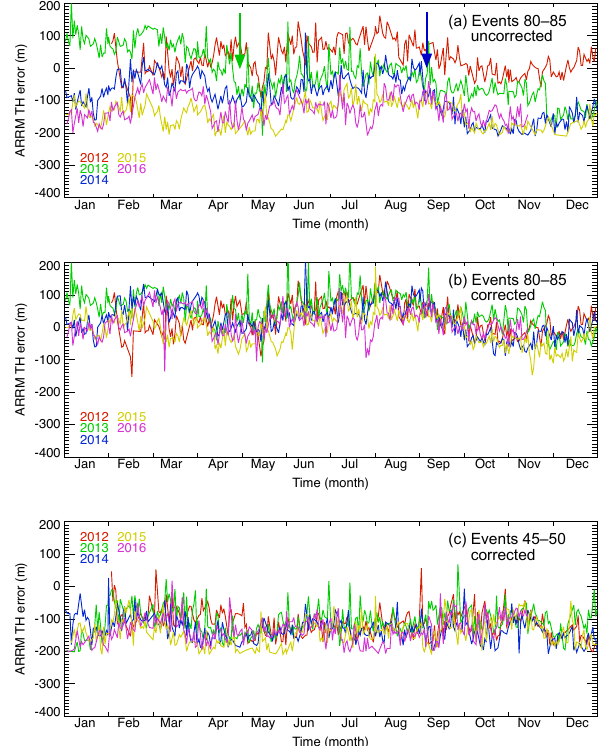
Figure 9. Daily averaged TH errors from ARRM analysis in bins of five events for the center slit over a year. Colors indicate a differ- ent year. (a) Event bin 80 to 85 ( ∼ equatorial) with no adjustment made for the distinct drop on 25 April 2013, when the spacecraft pitch was adjusted ∼ 6arcsec, or for an unconfirmed adjustment on 5 September 2014 resulting from inclination adjustment maneu- vers. The drops are distinct, suggesting that ARRM may be able to detect TH changes of ∼ 100m in the absence of other effects. (b) Event bin 80 to 85 ( ∼ equatorial) with the two adjustments in- cluded. (c) Event bin 45 to 50 ( ∼ 45 ◦ S) with adjustments included shows a seasonal cycle of ± 70m. Remaining variations could be due to true pointing changes, errors in the GPH data that we used in our analysis, or variations in